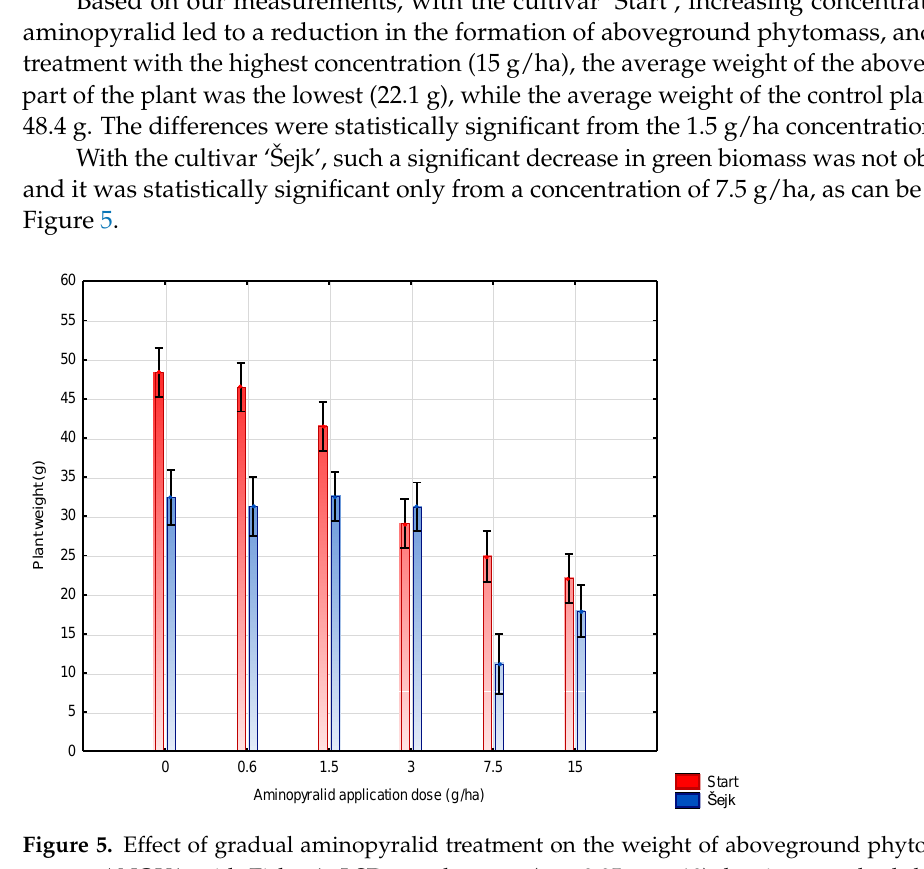
Figure 4. Effect of gradual aminopyralid treatment on root collar diameter in millimeters; ANOVA with Fisher´s LSD post hoc test (α = 0,05; n = 10), bar is a standard deviation, significantly different classes of values were added in separate Table S2 in Supplementary Materials.